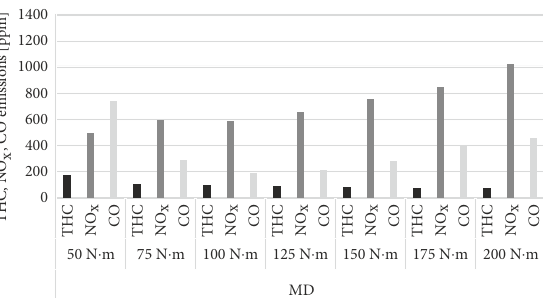
Figure 19. Emission of THC, NO x and CO for MD sample with operating parameters of engine 3000 rpm